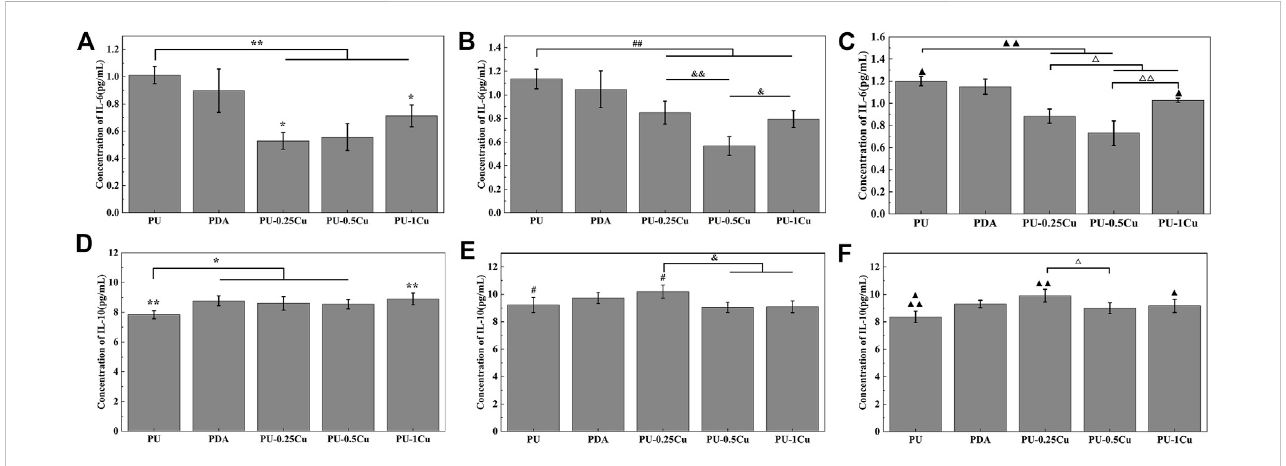
FIGURE 8 (A – C) Concentration of IL-6 secreted into the culture medium for 24, 48, and 72 h. Statistically signi fi cant differences are shown as *p < 0.05 , & p < 0.05 , △ p < 0.05 , ▲ p < 0.05 , **p < 0.01 , ## p < 0.01 , && p < 0.01 , △△ p < 0.01 , and ▲▲ p << 0.01 . (D – F) Concentration of IL-10 secreted into the culture medium for 24, 48, and 72 h. Signi fi cant differences are represented as *p < 0.05 , # p < 0.05 , & p < 0.05 , ▲ p < 0.05 , △ p < 0.05 **p < 0.01 , and ▲▲ p < 0.01